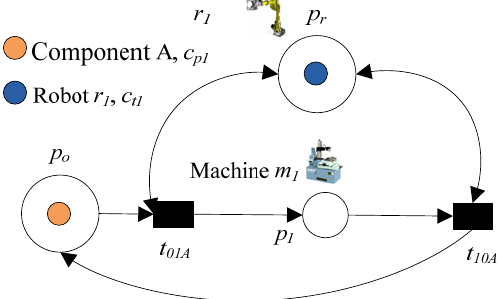
Figure 3. The CROPN of the system shown in Figure 2a.